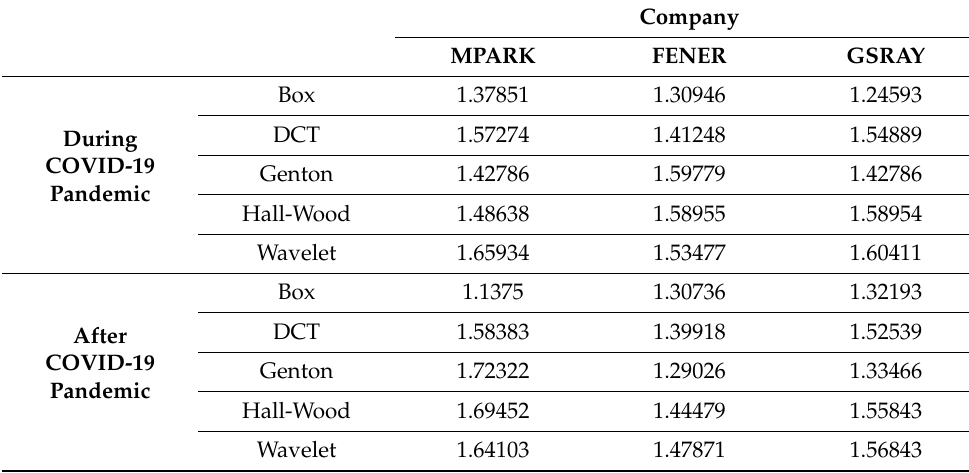
Table A1. Fractal dimensions for the social